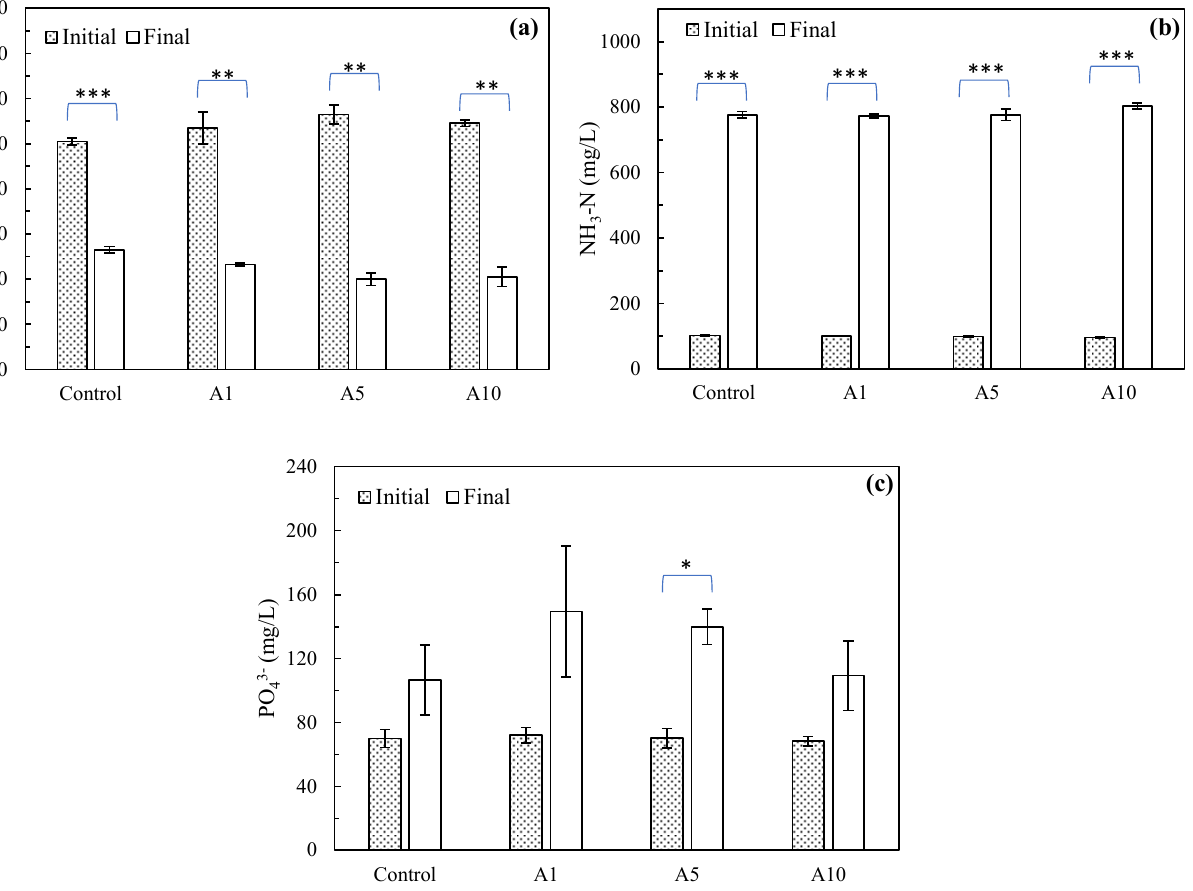
Figure 3. COD ( a ), ammonia ( b ), and phosphate ( c ) concentrations before and after AD of dairy ma- nure with the addition of different concentrations of AF-BC. One-way analysis of variance (ANOVA) was performed among each group compared ( p < 0.05 *, p < 0.01 **, and p < 0.001 ***).